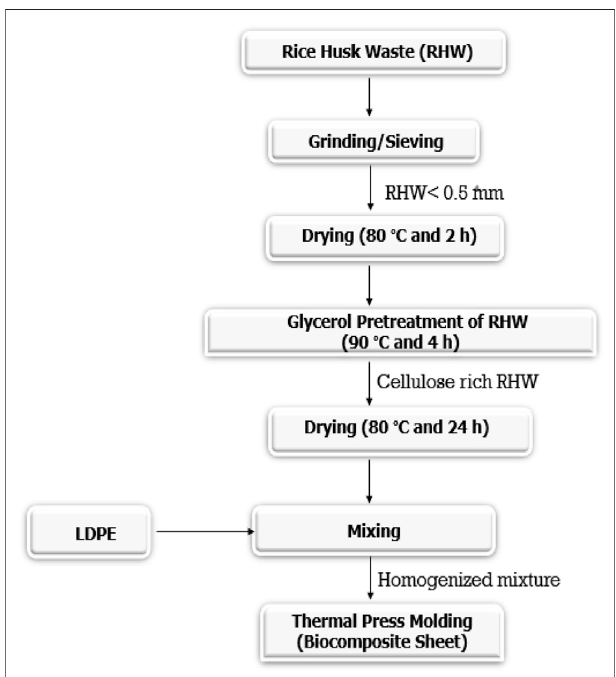
FIGURE 1 | Schematic representation of biocomposite fabrication as reported by Sulaiman et al. (2020).